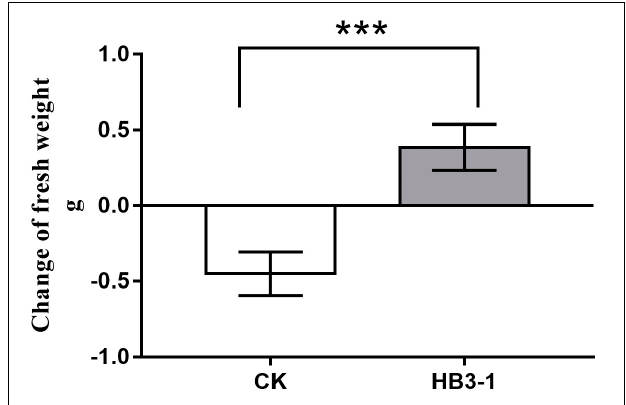
FIGURE 4 | Change of fresh weight of seedlings inoculated with HB3-1 and the control group after 100 days of culture on cultivation substrate. *** means a difference that is significant at level α =